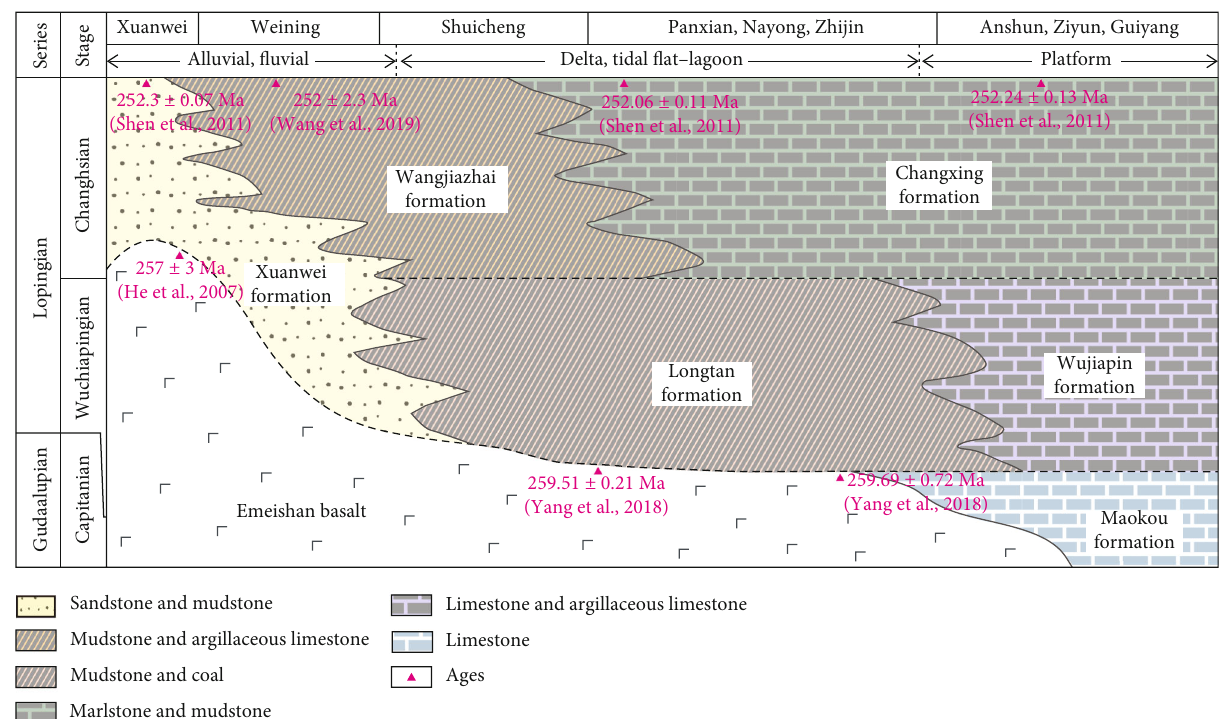
Figure 2: Correlation of lithological units of western Yangtze platform in the Late Permian (age data are from [23, 28 – 30]).